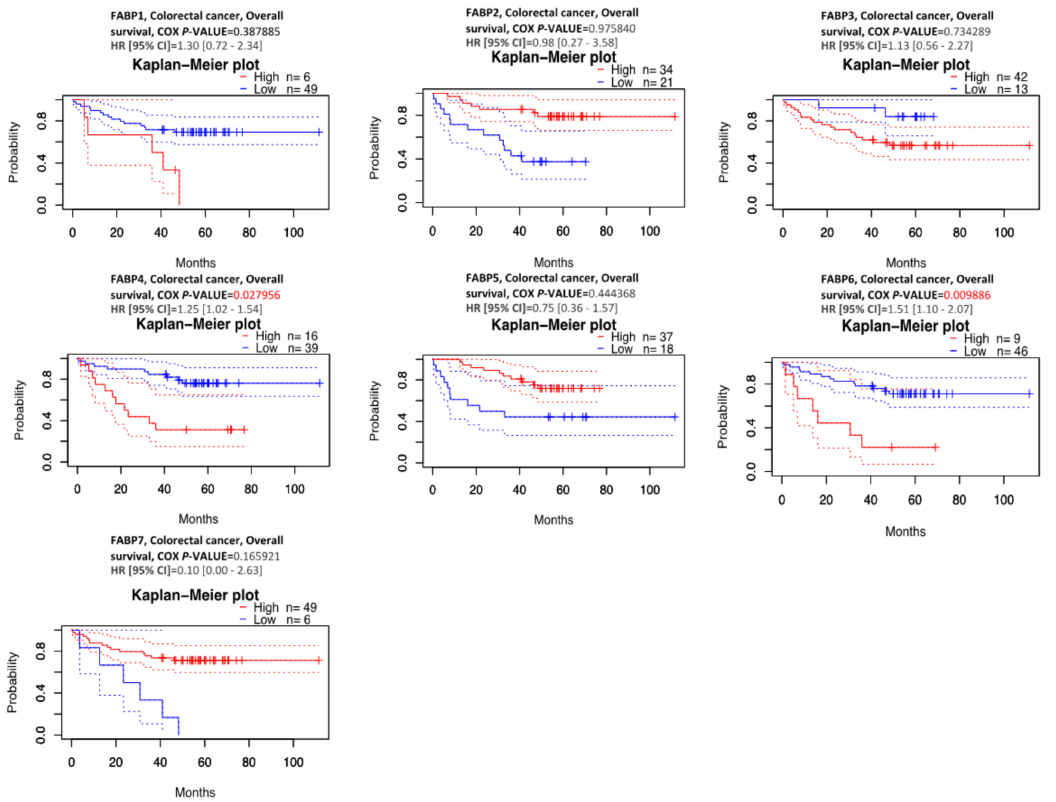
Figure 5. Kaplan–Meier plot of fatty acid-binding protein ( FABP ) expression in CRC patients ( n = 55) for overall survival analysis (PrognoScan database). The survival curves for the high (red) and low (blue) expression groups are dichotomized at the optimum cutpoint. The time on the X-axis corresponds to the survival rate on the Y-axis. Dotted lines also show the 95 percent confidence intervals for each group. The hazard ratio (HR) is a relative prognostic measure of patients with CRC. Log (rank p ) was used to determine the level of prognostic significance of patients with CRC. Furthermore, log (rank p < 0.05) was interpreted as a significant difference in the prognostic expression of patients with CRC. The prognostic value of FABP4 and FABP6 showed significance in terms of overall survival outcomes in CRC (Cox p <